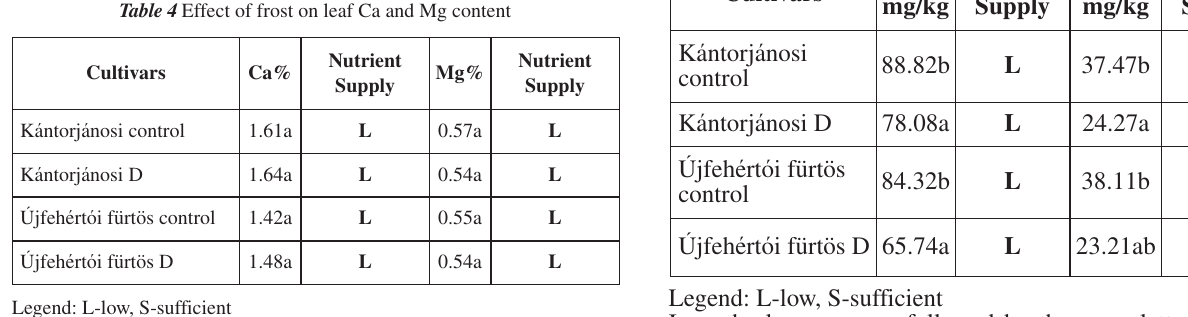
Legend: L-low, S-sufficient In each clumn, means followed by the same letter are not significantly different (P<0.05). Nutrient contents were expressed in percentage of dry matter